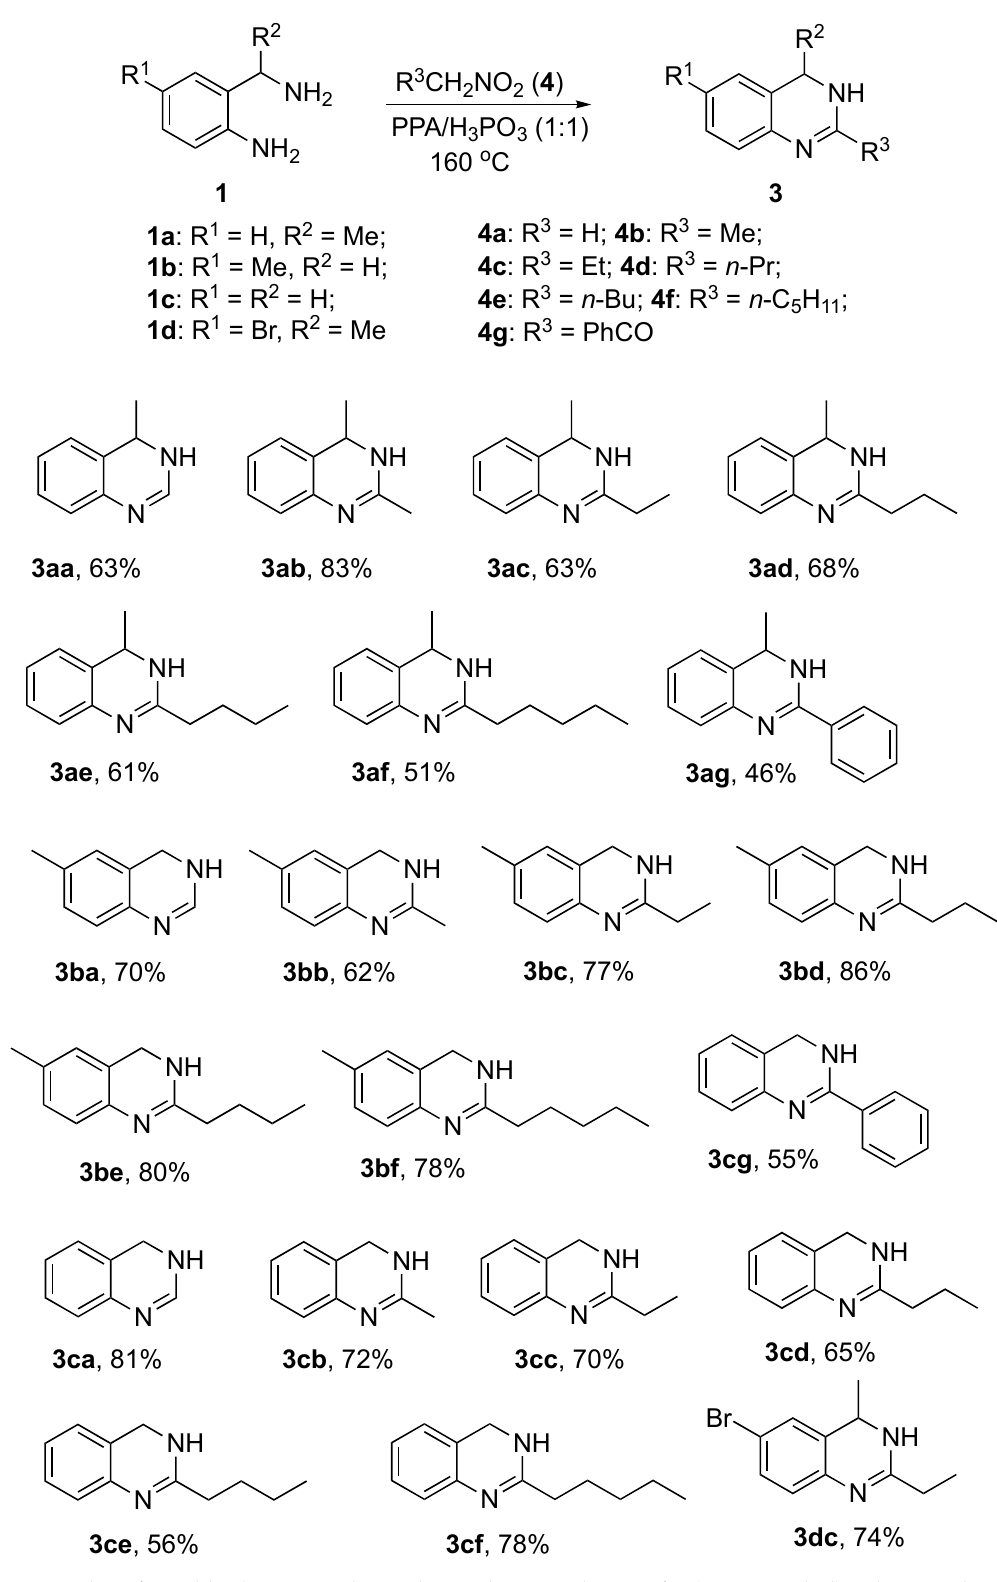
Scheme 4. Examples of 3,4-dihydroquinazolines obtained in annulation of 2-(aminomethyl)anilines and nitroalkanes. Isolated yield of purified products is listed.